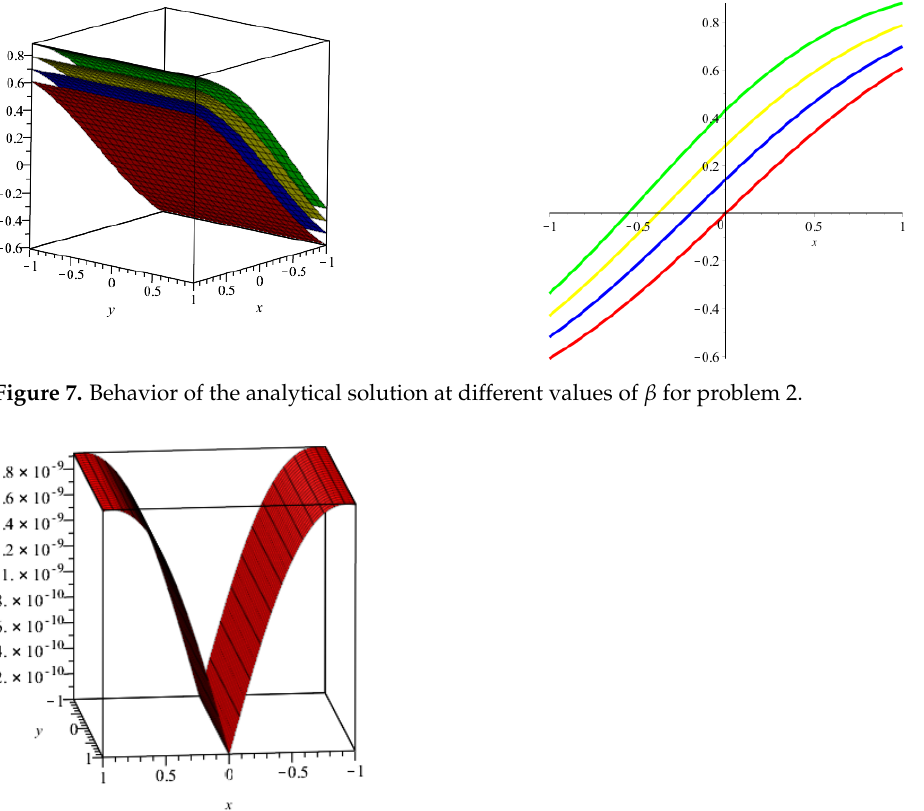
Figure 6. Behavior of the analytical solution for problem 2 at β = 0.8,0.6.